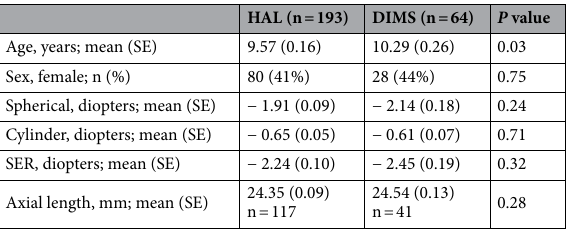
Table 1. Baseline characteristics of the children in the two groups. DIMS defocus incorporated multiple segments, HAL highly aspherical lenslets, SE standard error, SER spherical equivalent refraction.